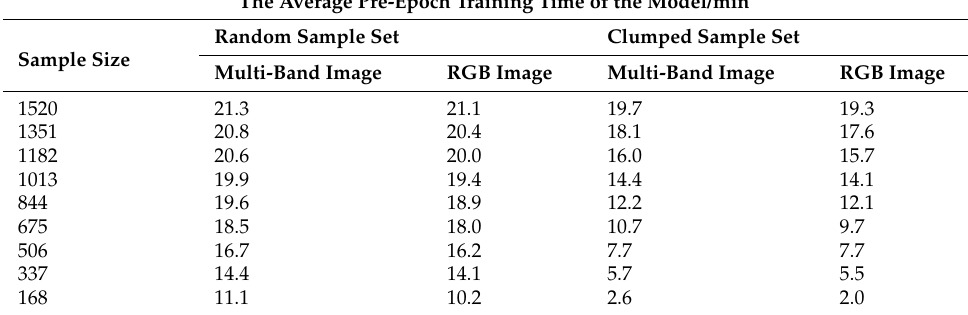
Table 3. The average per-epoch time was obtained with the random and clumped labeling approaches used to train the Mask R-CNN architecture with the RGB and Multi-band images. Sample sizes are sorted in descending order by a percentage of